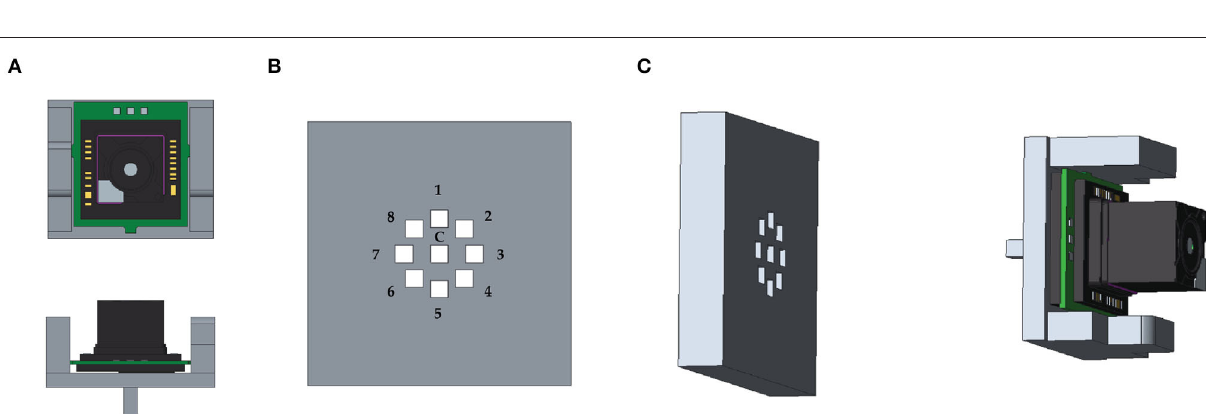
FIGURE 6 | Experimental setting for the calibration procedure and the experimental session. 1 → The validation checkerboard holder. 2 → The validation checkerboard. 3 → The optical see-through head mounted display (OST HMD) holder. 4 → The the OST HMD. 5 → The tracking camera. 6 → The optical shutter. 7 → The optical combiner. 8 → The viewpoint camera. 9 → The 3D printed mounting template.